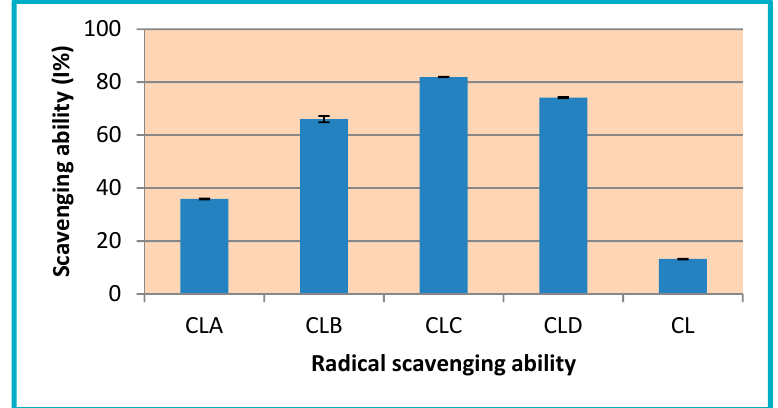
Figure 5. DPPH radical scavenging ability (I%) of chitosan nanoparticles and its derivatives (CL, CLA-CLD).